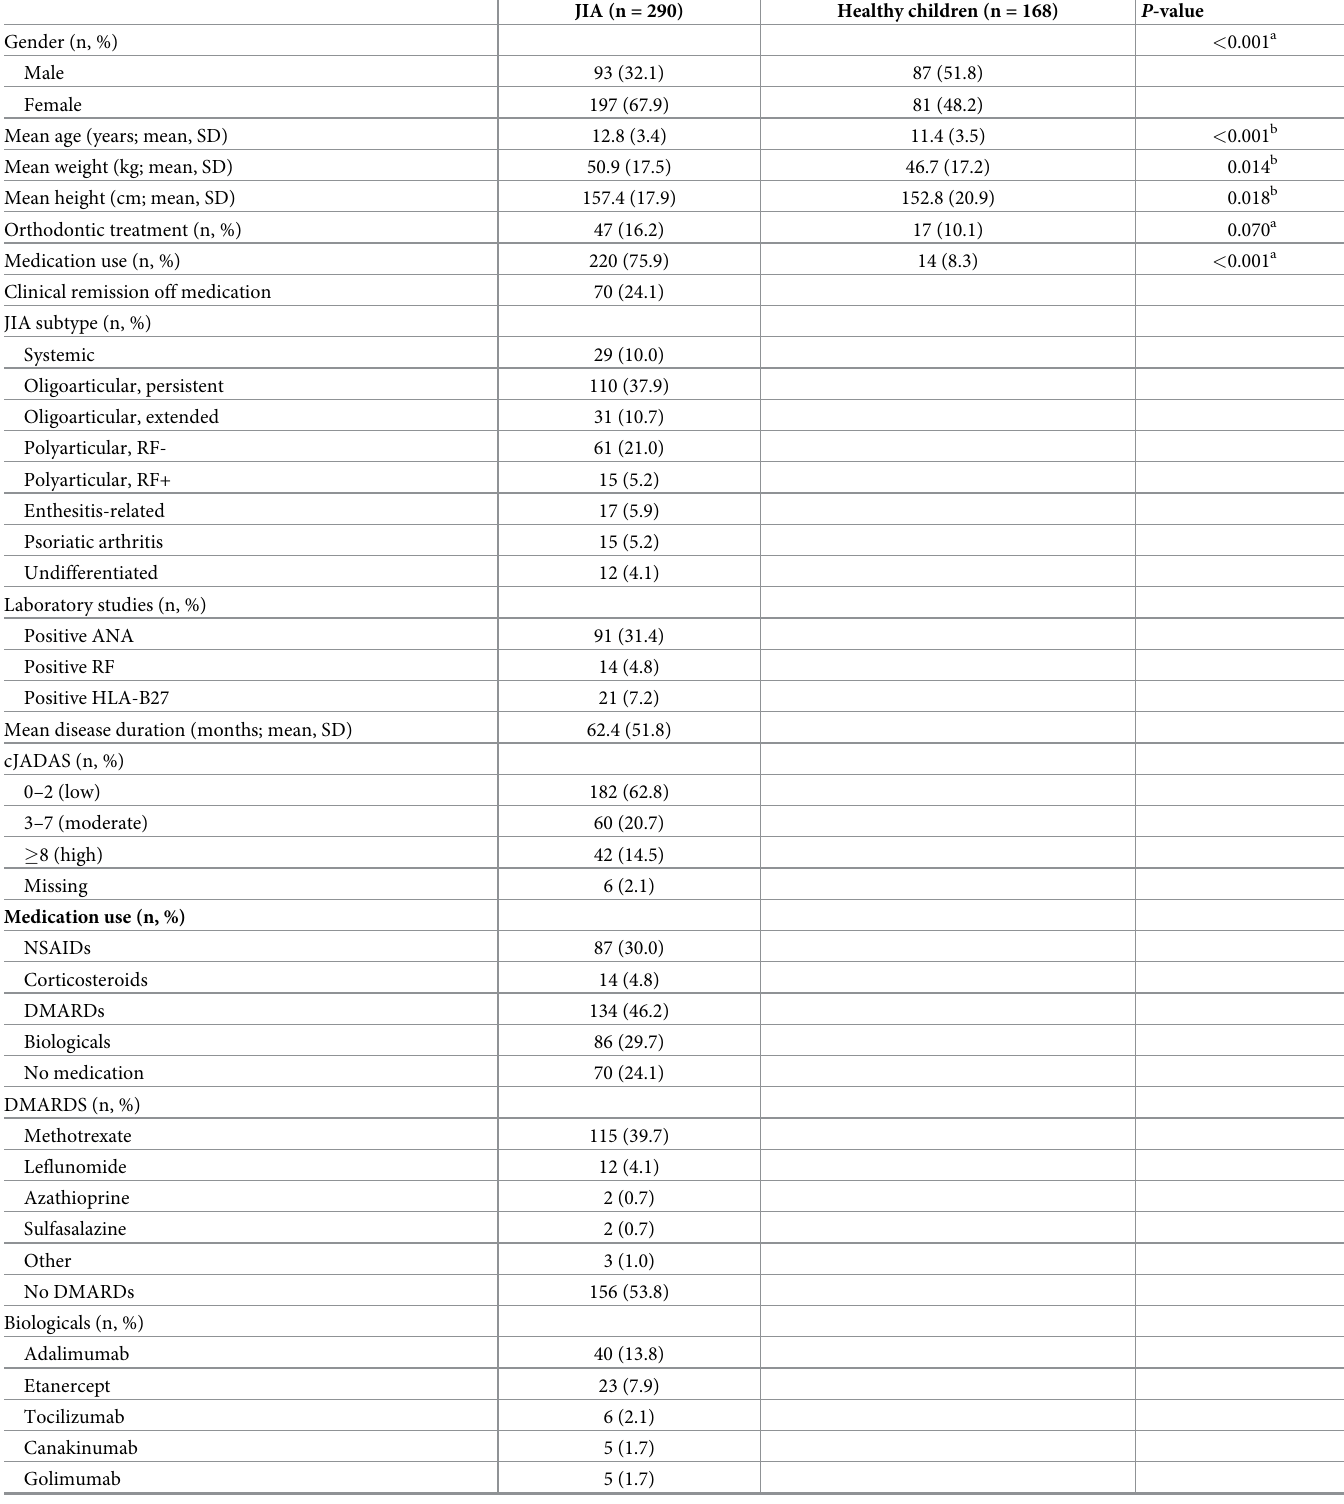
Table 1. Demographics and AMVBF of children with JIA and healthy